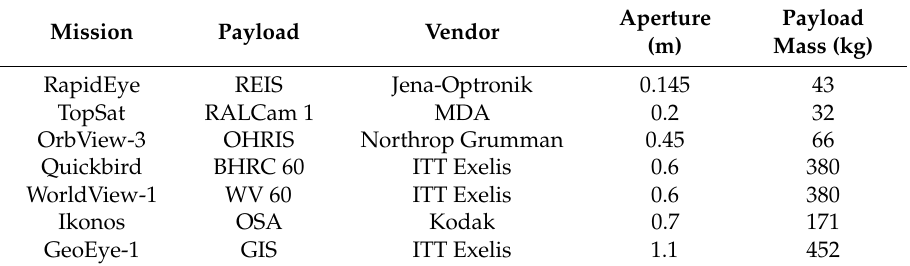
Table A1. Figures of merit, scaling and weighting factors in single-objective optimization.